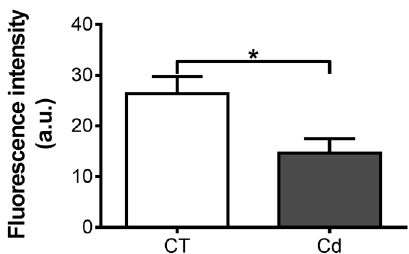
Figure 1. Hypoxia-inducible factor 1 (HIF-1) DNA-binding ability in nuclear extracts of kidneys of control and cadmium-exposed fetuses. Two micrograms of nuclear extracts were used per sample. Each sample was run in duplicate. The bars represent means ± SEM, n = 5. * p = 0.0307, Student’s t -test.